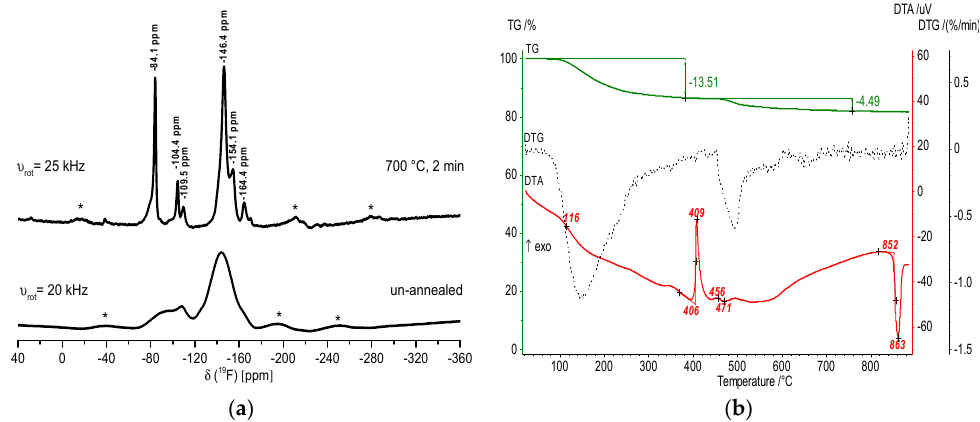
Figure 7. 19 F MAS spectra of un-annealed and annealed Ca 2 AlF 7 xerogel at 700 ° C for two minutes ( a ) and TG/DTA heating curves ( b ). The spinning sidebands in the NMR spectrum are located under the *